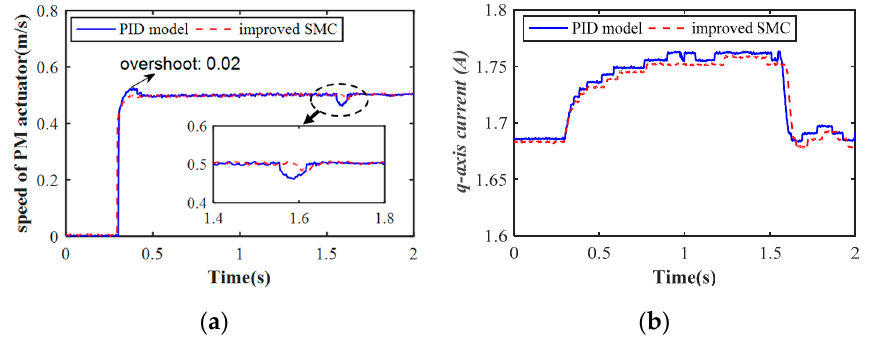
Figure 11. ( a ) Speed curves of segmented PMLSM with different models during drive process; ( b ) q -axis currents of segmented PMLSM with different models during drive process.